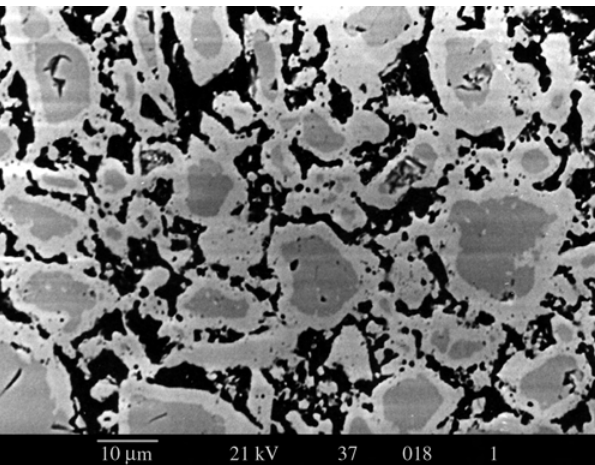
Figure 6. Micrograph of the composite with 40 wt. (%) Nb pyrolyzed at 1400 °C. pure alumina, as well as that of material (Al carbon content (13.2 wt. (%) C), what is in agreement to the results observed for the XPS analysis. The hardness values are associated with the major NbC content present on the surface of the